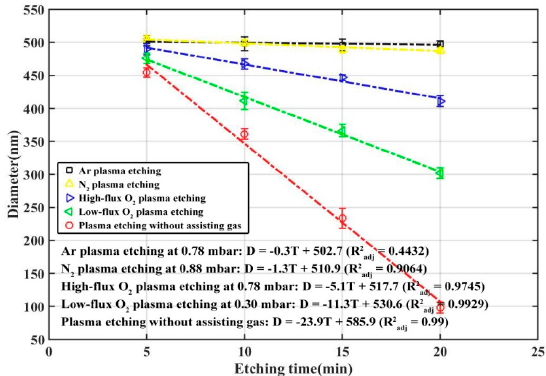
Figure 3. Size of the PS nano-spheres as a function of etching time for different gas types.